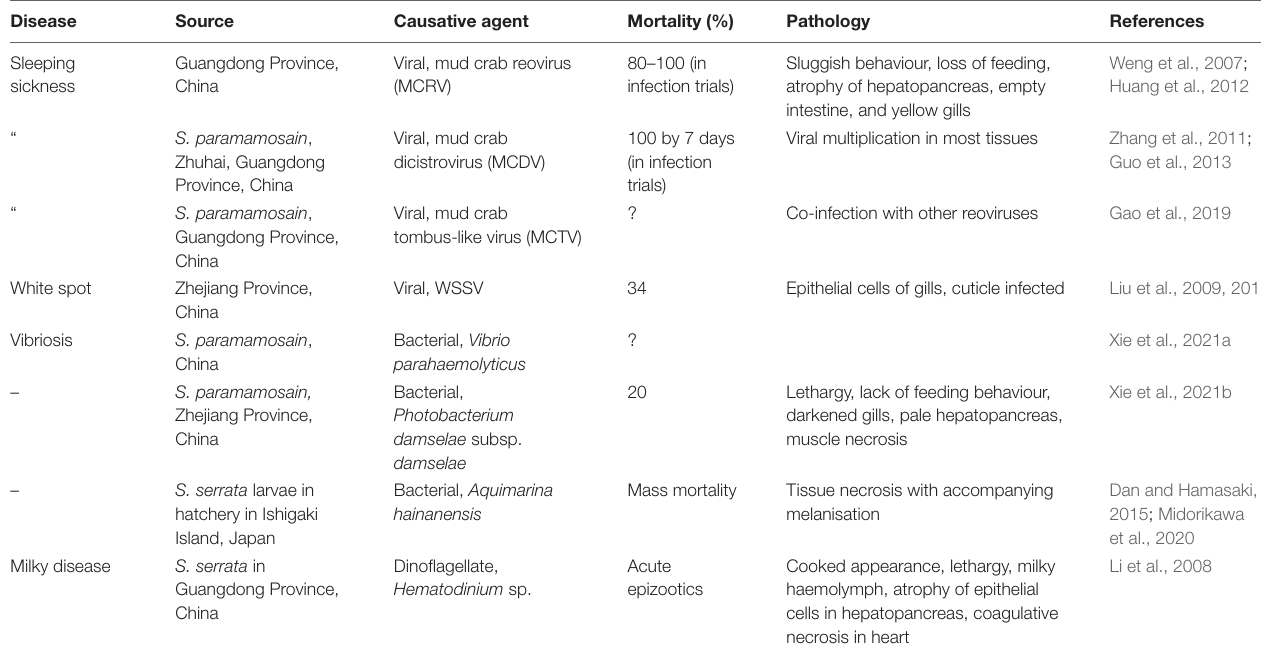
TABLE 2 | Key diseases of mud crabs ( Scylla serrata and S. paramamosain ) in cultivation.